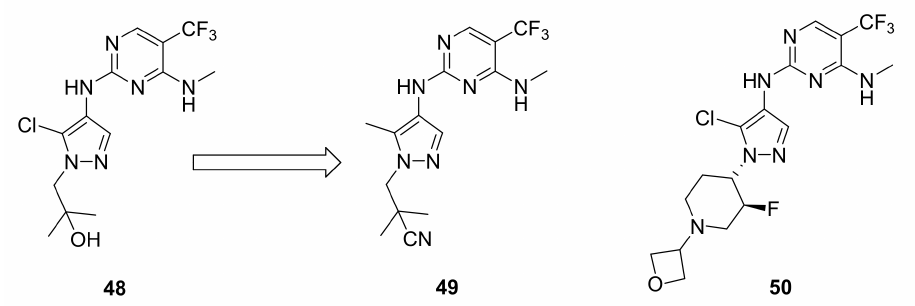
Figure 57. Development of compounds 49 and 50 from structural modification of compound 48 .